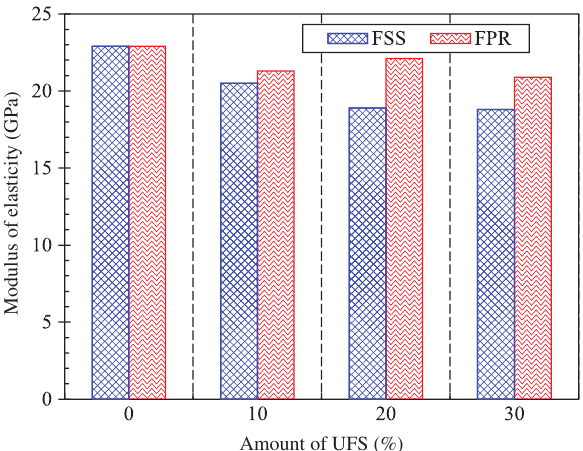
Figure 10: Modulus of elasticity of concrete having various UFS